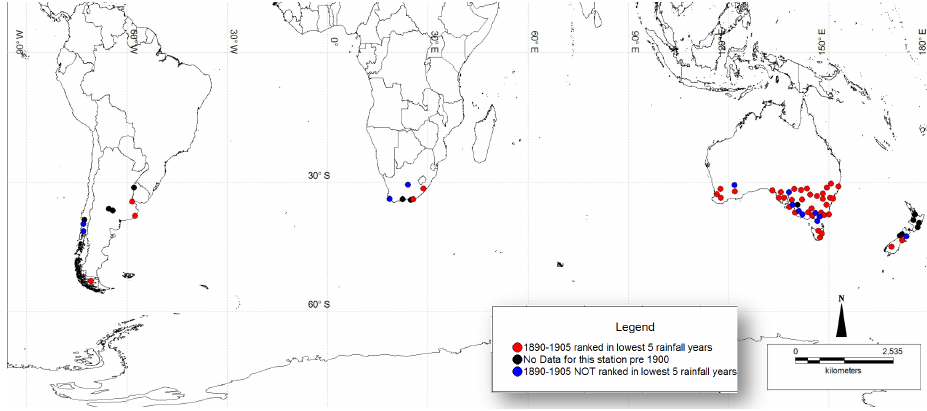
Figure 5. Stations where the period 1890–1905 was listed in the top five lowest rainfall years (shown in red).